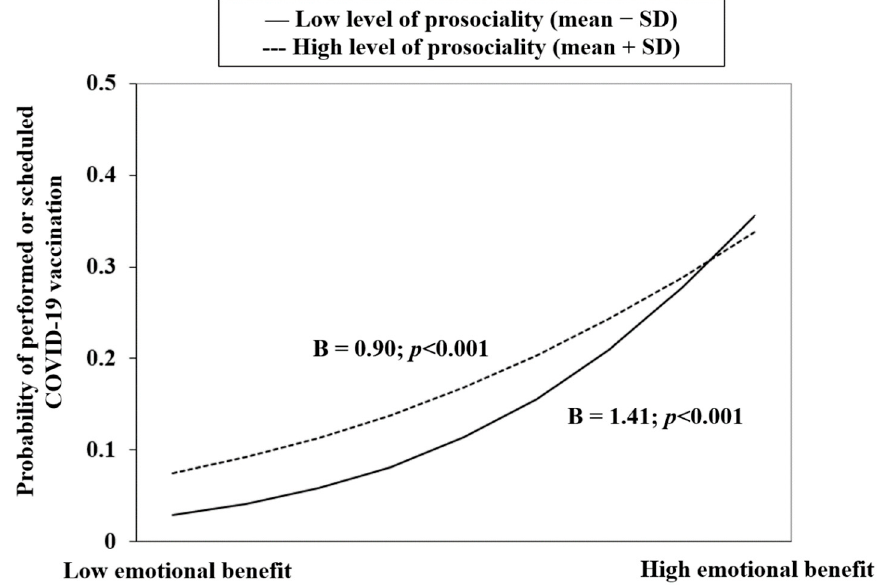
Figure 2. Prosociality moderated between emotional benefit and